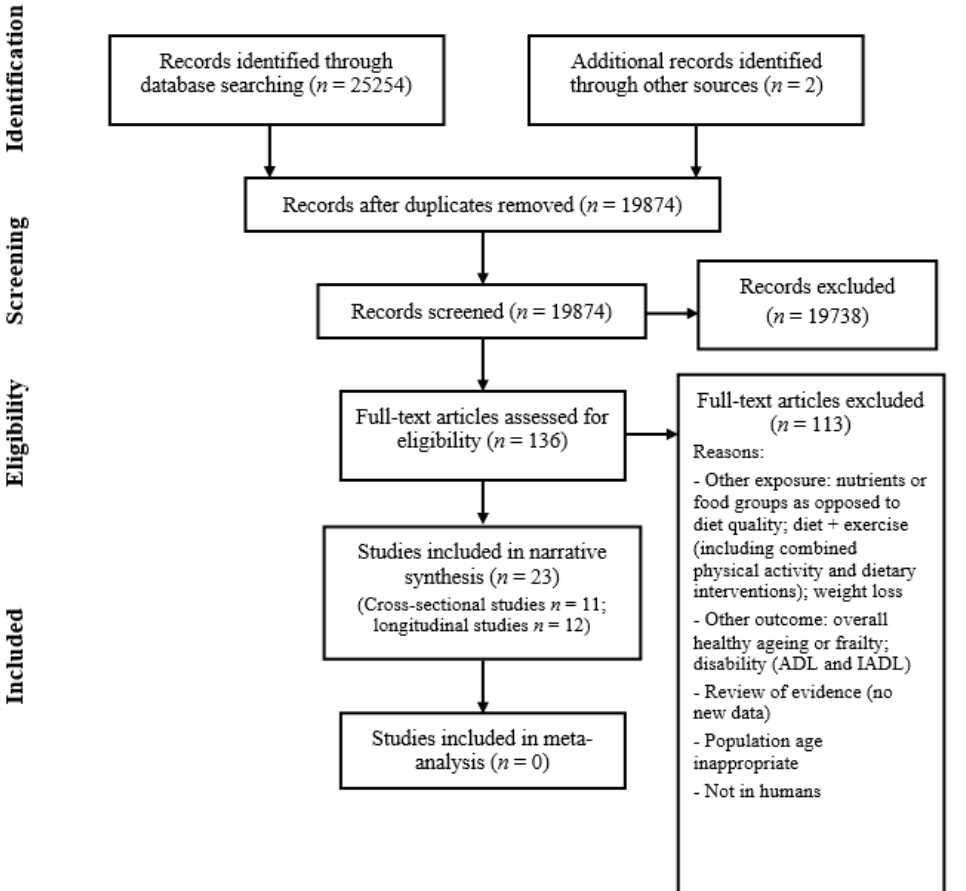
Figure 1. Flow diagram summary of articles identified in search and showing the selection of studies for inclusion in the review.